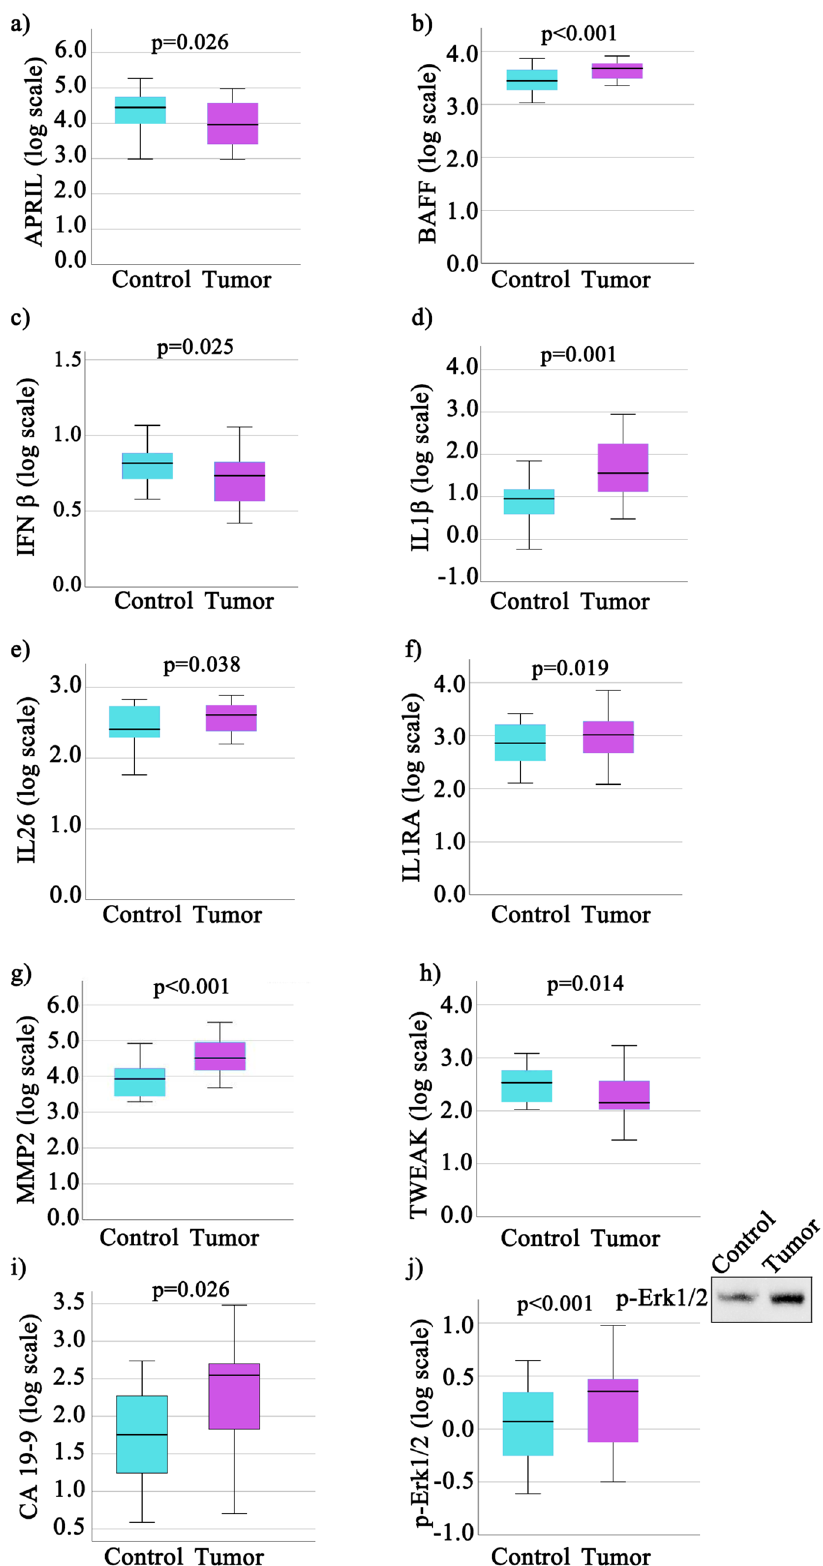
Figure 1. Box-plots of log-transformed biomarker values in tumor and paired normal tissue samples. Selected log- transformed biomarker values had a normal distribution. ( a ) APRIL; ( b ) BAFF; ( c ) IFN β; ( d ) IL1β; ( e ) IL26; (f) IL1RA; ( g ) MMP2; ( h ) TWEAK; ( i ) CA19-9; ( j ) p-Erk1/2. In box-plot ( j ) the source data was the average relative density of immunoblot bands of all tumor and paired normal tissue samples; the cropped insert shows a representative immunoblot example. The original immunoblots are available in Supplementary Figure S1; p values resulting from comparison of control and tumor means of log-transformed levels through t Student test are written above each boxplot